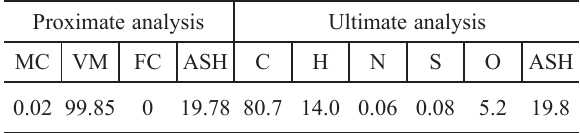
Table 2 – PE proximate and ultimate analysis of LDPE 16